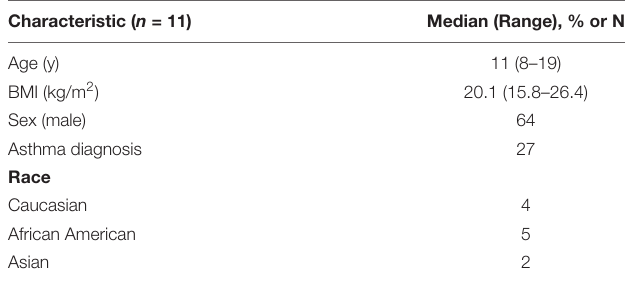
TABLE 1 | Demographic characteristics of all participants with two or more HILD tests ( n =